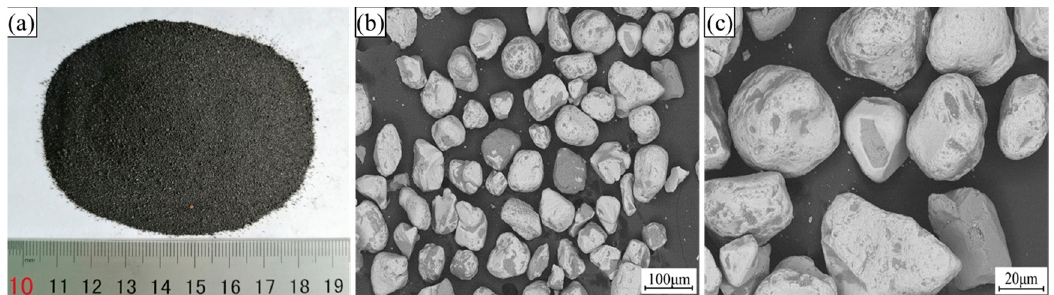
Figure 2. The microscopic morphology of sea sand ore. ( a ) Original state; ( b ) 200×; ( c ) 500×